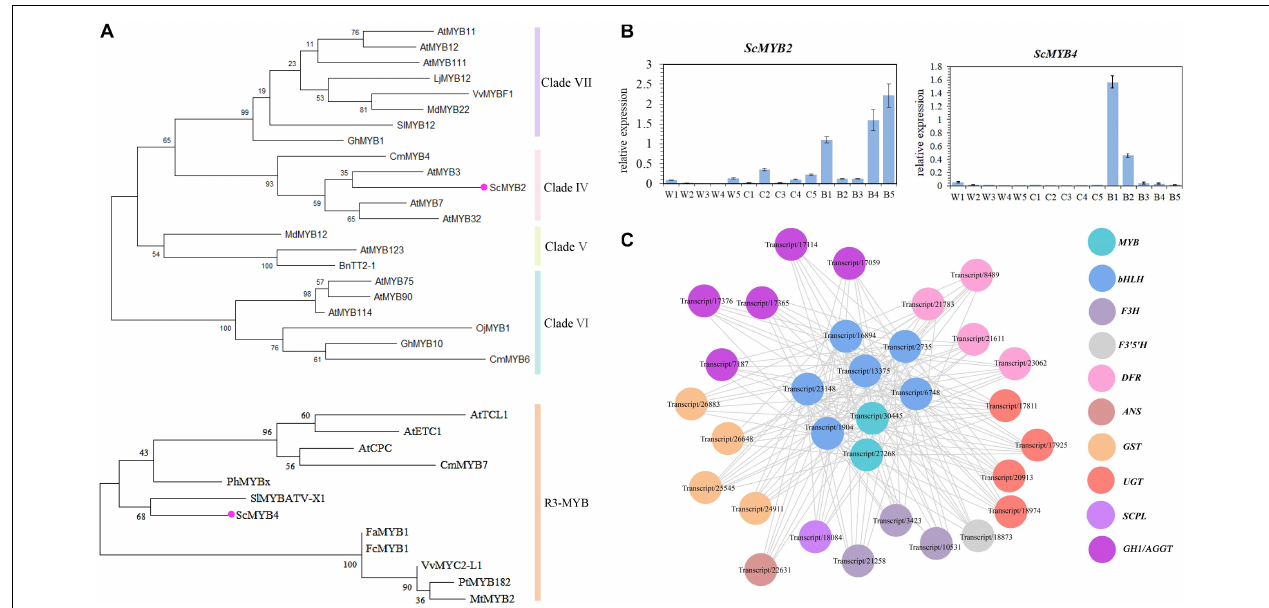
FIGURE 9 | Identification of MYBs involved in the regulation of polyacylated anthocyanin biosynthesis using bioinformatics and qRT-PCR analysis. (A) Amino acid sequences of ScMYB2 and ScMYB4 and arabidopsis MYBs belonging to the Clade IV-VII and R3-MYB and some MYB sequences from other plants were used to build a phylogenetic tree based on maximum likelihood, which was employed to infer the MYB candidates of cineraria involved in polyacylation modification. (B) The expression profiles of ScMYB2 and ScMYB4 during the ray florets developed were confirmed by qRT-PCR. The data were the mean ± SD from three biological replicates. (C) The relationship between ScMYB2 , ScMYB4 and the key structural genes related to delphinidin biosynthesis and polyacylation modification of cineraria in cluster 8 of DEGs was analyzed by gene co-expression network. The circles represented the transcripts, and the grey lines represented connectivity among the